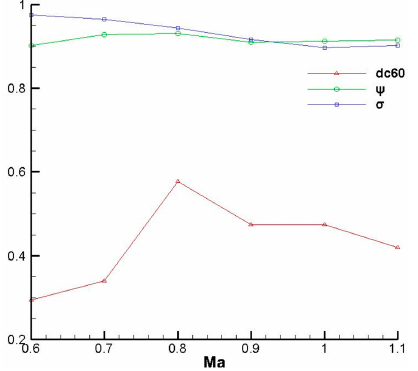
Figure 19. Aerodynamic performance at off-design conditions.